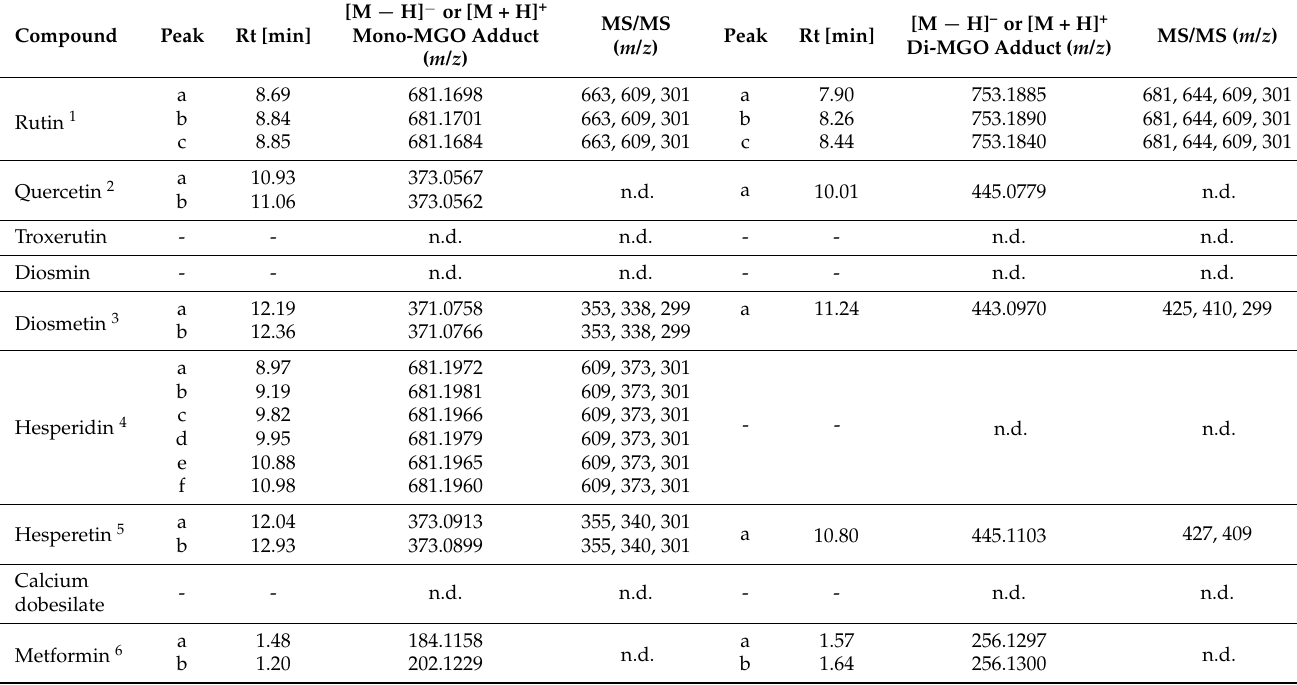
Table 2. Adducts of methylglyoxal and investigated compounds formed after 1 h of incubation in pH 7.4 of phosphate buffer solution at 37 ◦